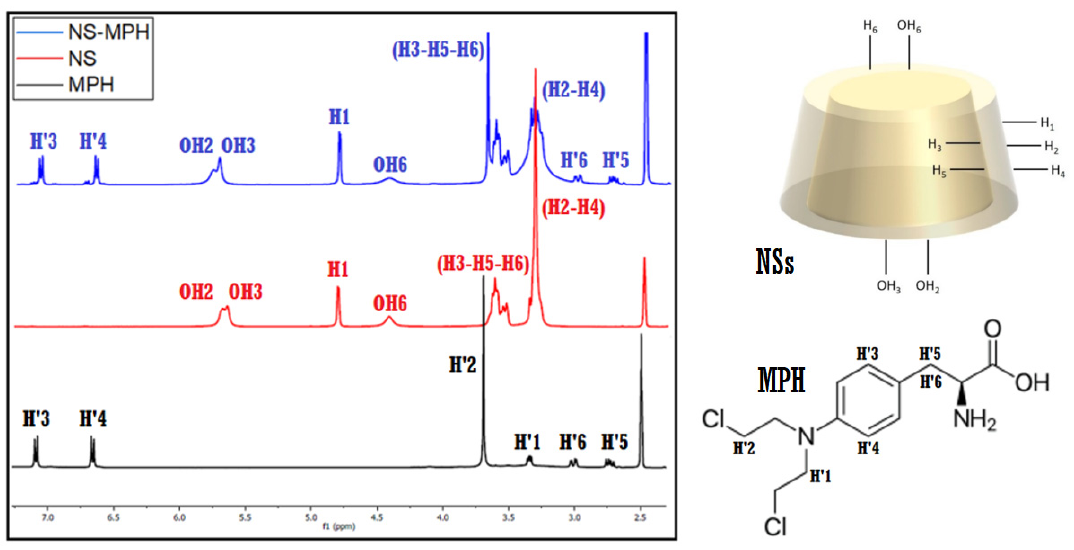
Figure 3. 1 H-NMR spectra (400 MHz, DMSO-d 6 ) of MPH, NSs, and NSs–MPH.